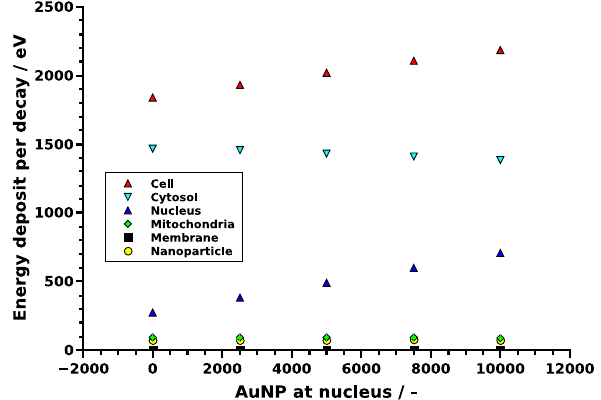
Figure 3. Energy deposit per decay in dependence of the AuNP location. For the whole CHO cell (red) and the cytosol (light blue), here excluding the AuNP (yellow), the nucleus (dark blue) and the 90 mitochondria (green) and the cell membrane (black). The errorbars are in the size of the symbols and therefore not visible. For details see the text.